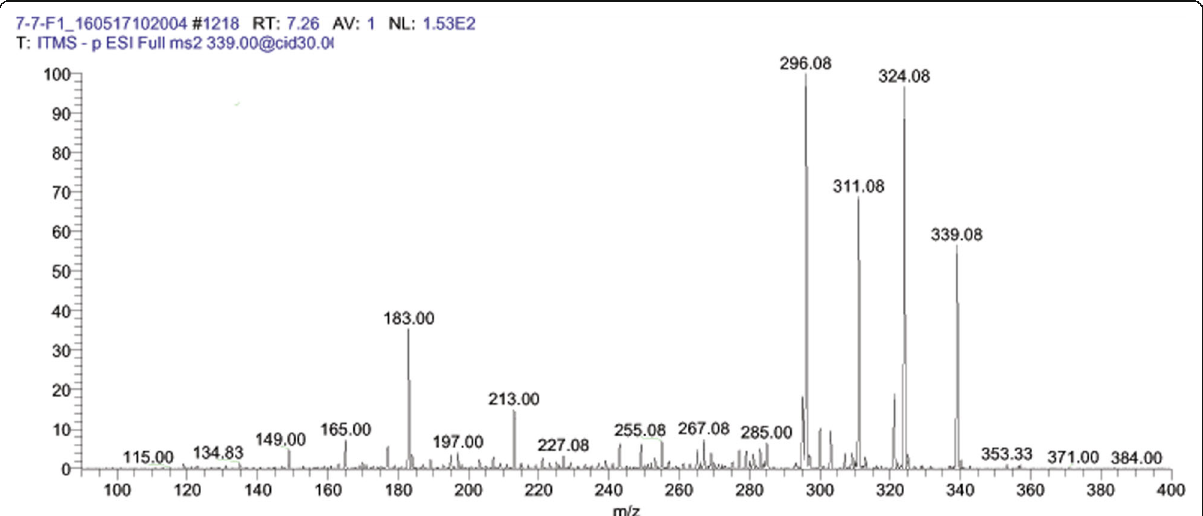
Fig. 2 LC MS/MS Chromatogram of fraction 4 (F4) from hexane extracts of Glycyrrhiza glabra showing 6-aldehydo-isoophiopogonone